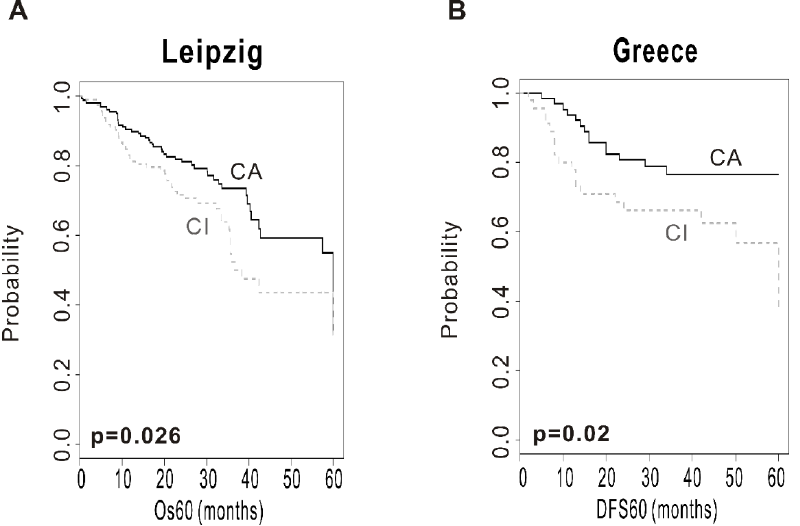
Figure 2. Construction of the prediction model and evaluation of predicted outcome. ( A ) Kaplan–Meier plots of overall survival (OS) at 5 years in the Leipzig cohort. ( B ) Kaplan–Meier plots of disease-free survival (DFS) at 5 years in the Greece cohort. Patients were stratified by CSMD1 signature. The differences between groups were significant, as indicated by the log-rank test.